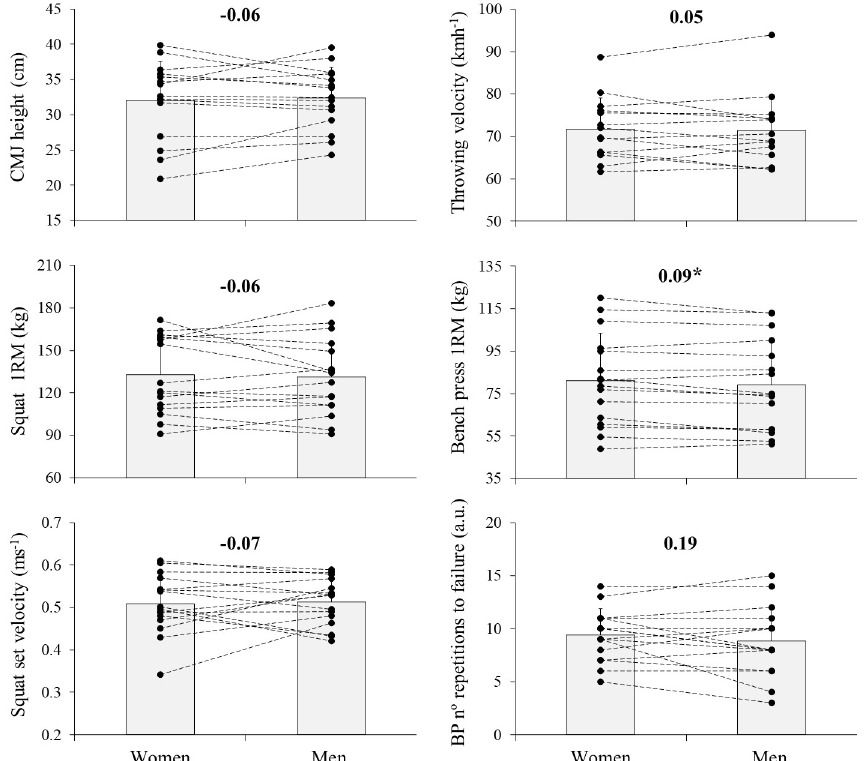
Fig 2. Comparisons of ballistic (countermovement [CMJ] height and throwing velocity), maximal dynamic strength (squat and BP one-repetition maximum [1RM]) and strength-endurance (number of repetitions-to- failure in BP and average velocity of the set in the squat) performance between both testing sessions that differed in the sex of the evaluators. The Cohen’s d effect size ([women evaluators—men evaluators] / SD both; bold numbers) are indicated. Statistical significance: � P < 0.05. Data are presented as means and standard deviations.